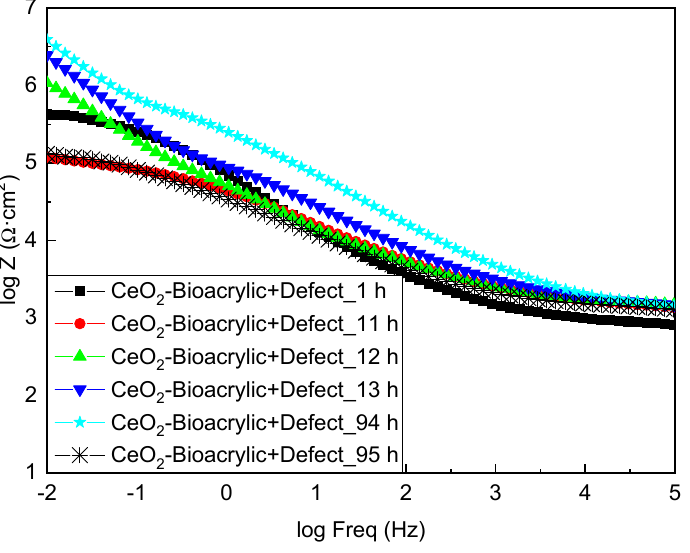
Figure 7. Bode plots of CeO 2 —Bioacrylic binder with an artificial defect after different immersion times in 3.5 wt% NaCl solution.